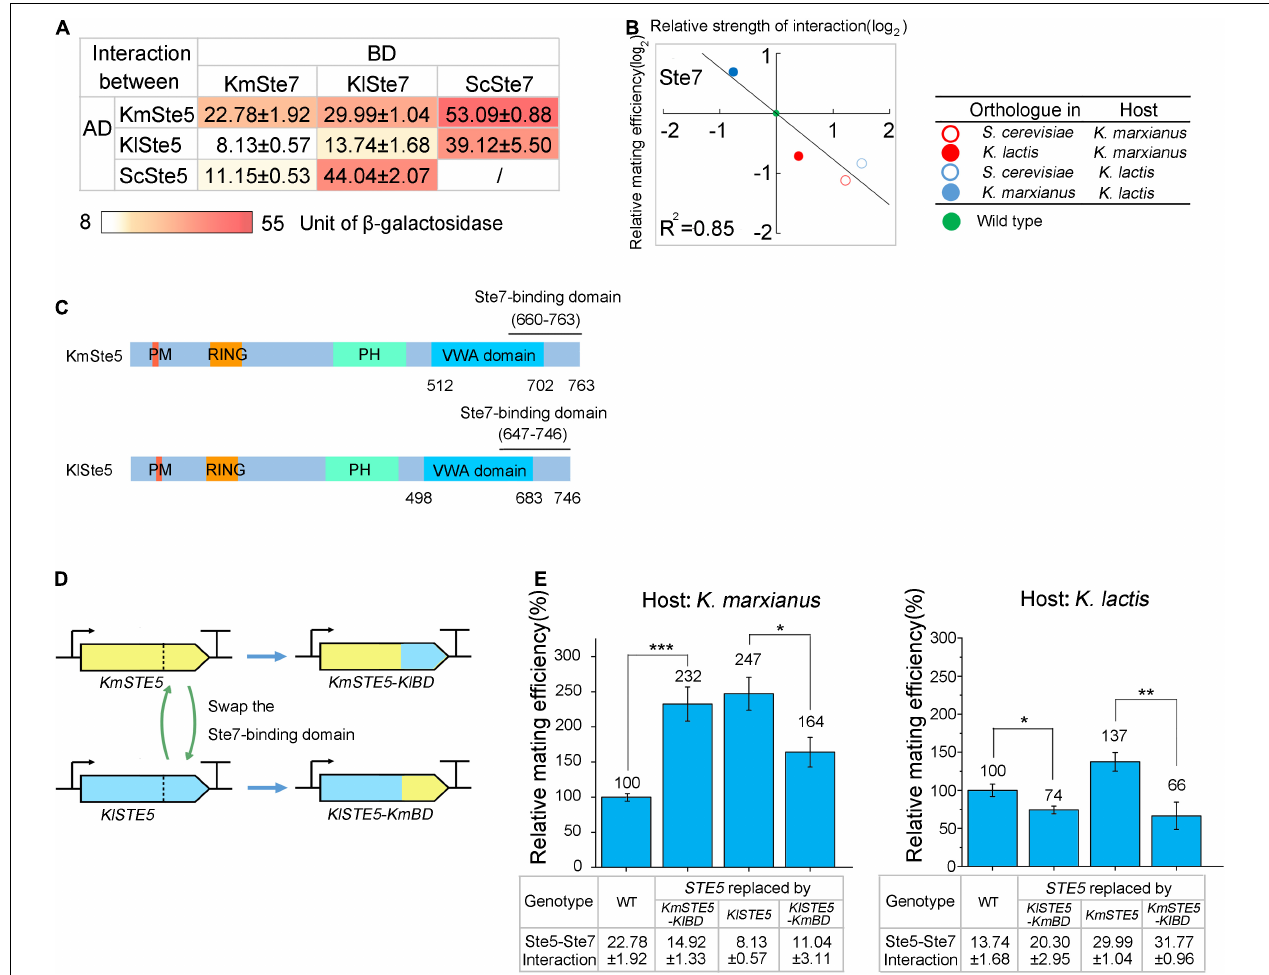
FIGURE 4 | The strength of interaction between Ste5 and Ste7 is negatively correlated with mating efficiency. (A) The strength of the interaction between the orthologs of Ste5 and Ste7. In a yeast two-hybrid system, orthologs of Ste5 were fused to Gal4-AD (AD) and those of Ste7 were fused to Gal4-BD (BD). The strength of the interaction between AD-fusion and BD-fusion proteins was indicated by the units of β -galactosidase, encoded by a lacZ reporter gene. The strength of the interaction between BD-fusion protein and AD alone was served as the blank and was subtracted. The value represented the mean ± SD from three different colonies. (B) The relationship between the relative mating efficiency and the strength of the Ste5-Ste7 interaction. The relative mating efficiency of the strain in which Ste7 was replaced by its ortholog was plotted against the strength of the interaction between host Ste5 and Ste7 ortholog. The binary logarithm of the values was used for plotting. (C) Schematic representation of domains of KmSte5 and KlSte5. Domains and potential Ste7-binding regions in KmSte5 and KlSte5 were identified by sequence similarity ( Supplementary Figure 2 ). Counterparts to FBD domain and Ste11-binding region in ScSte5 could not be identified in KmSte5 and KlSte5. (D) Schematic representation of swapping Ste7-binding domain between KmSte5 and KlSte5. (E) Relative mating efficiency of cells carrying chimeric Ste5. LHP506, LHP507, LHP703, and LHP704 were subjected to the assay of K . marxianus . LHP570, LHP571, LHP712, and LHP713 were subjected to the assay of K . marxianus . Value represented mean ± SD from three biological repeats (* p < 0.05, ** p < 0.01, *** p < 0.001). The strength of interaction was measured as (A) and the value represented the mean ± SD from three different